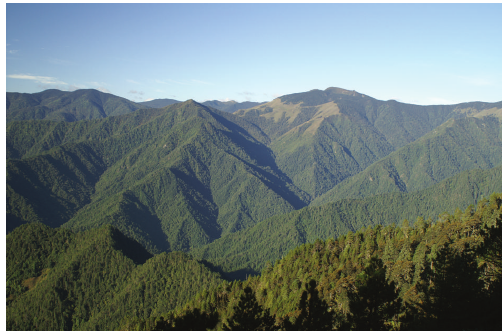
Figure 1: Study site Samage near the village of Gehuaqing in the Baimaxueshan Nature Reserve, Yunnan, China. The highest peak is Mount Samage (4166